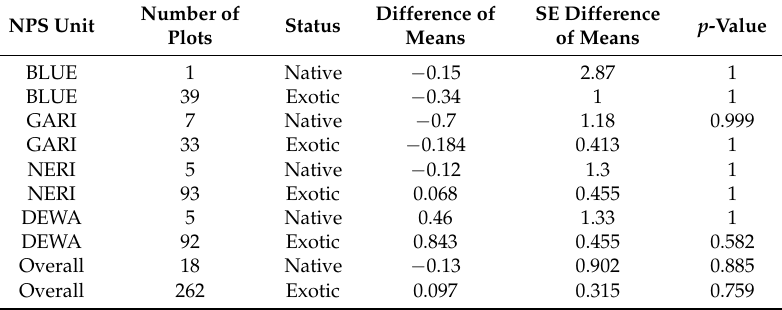
Table A3. Tukey method comparison for differences of means (disturbed–undisturbed) for average plant richness (number of species per m 2 ) for all undisturbed plots versus the disturbed plots for each NPS unit and all units combined prior to the disturbance